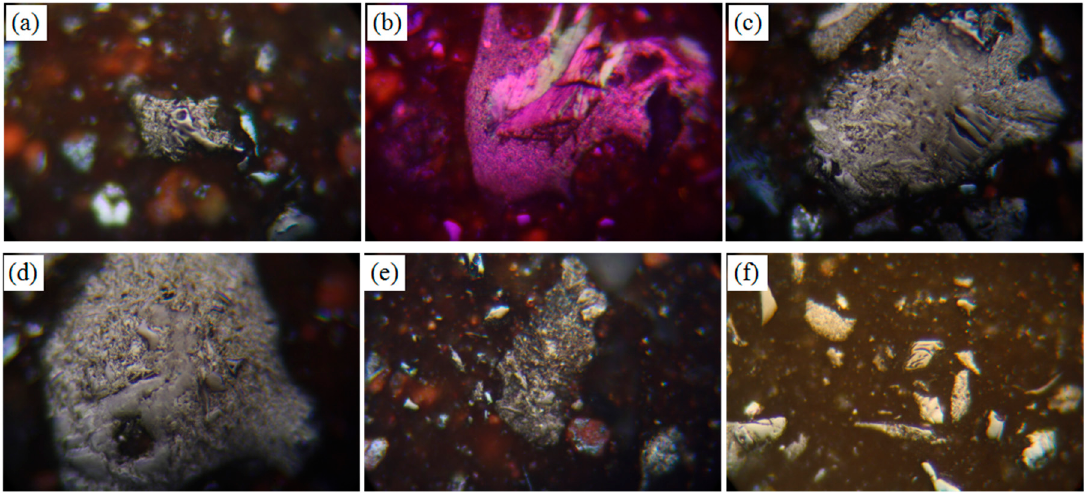
Figure 2. Microstructure of unconsumed fine coke in recycling dust: ( a – c ) granule inlay structure (GIS); ( d ) macro some (MS); ( e ) residue coke (RC); and ( f ) block structure (BS).